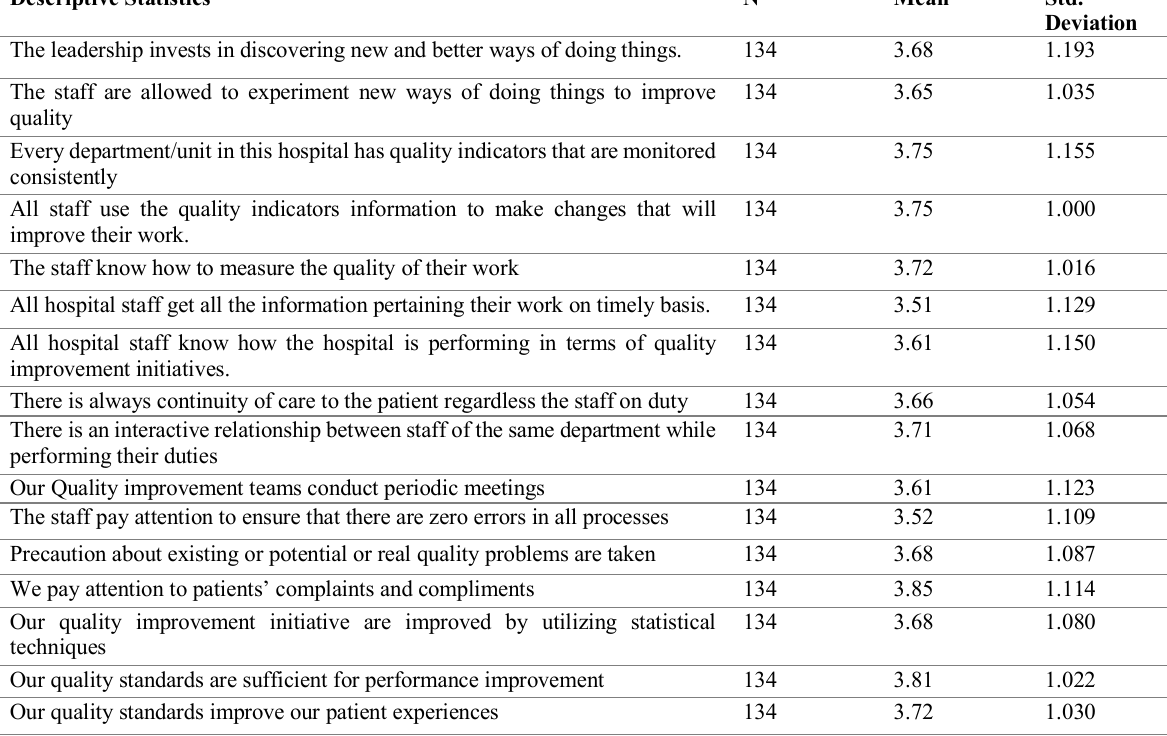
Table 7: Mean and standard deviation for continuous quality improvement